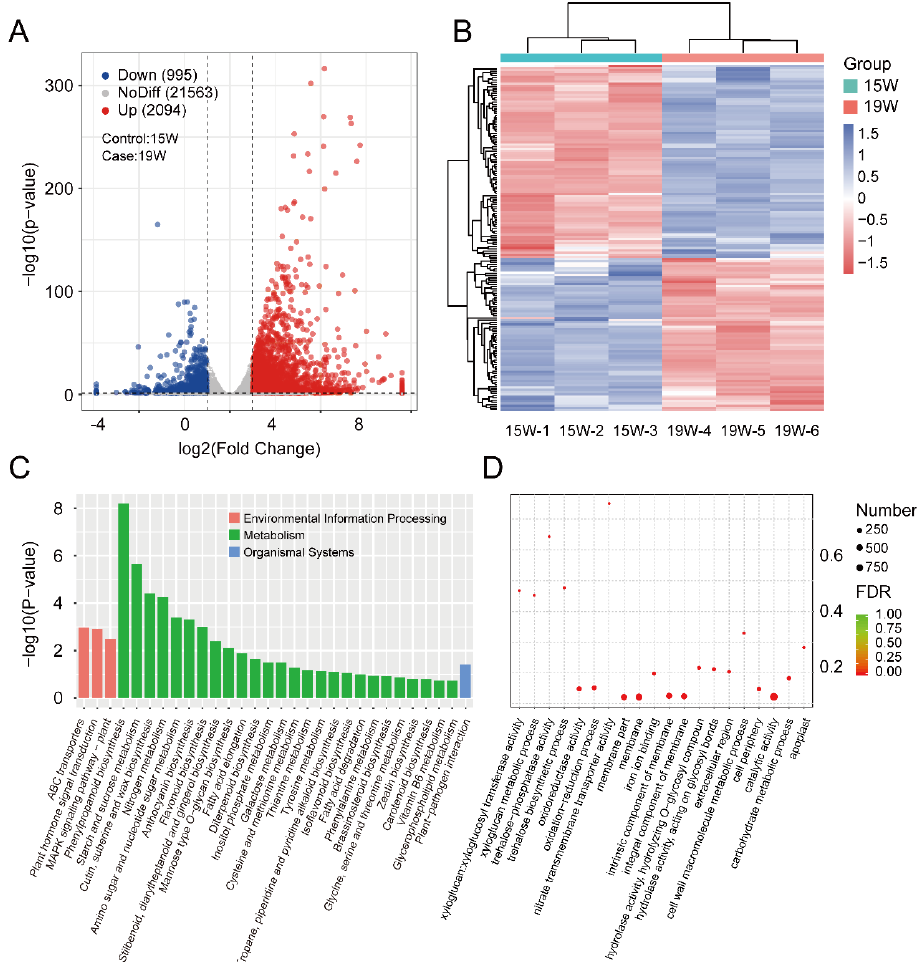
Figure 5. Identification of DEGs between 15 W and 19 W samples and functional enrichment analysis. ( A ) The volcano plot represents up-(red dots) and downregulated genes (blue dots), and no-different expression genes (grey dots). Dotted lines show the DEG cutoff value of FC > 2 with p < 0.05; ( B ) the heatmap of the gene expression level of DEGs, which were transformed by Z-score; ( C ) the histogram and (right panel) represent the significantly enriched gene ontology (GO) terms, which are divided into the biological process (BP), molecular function (MF), and cellular component (CC); ( D ) the bubble diagram shows the significantly enriched GO terms.